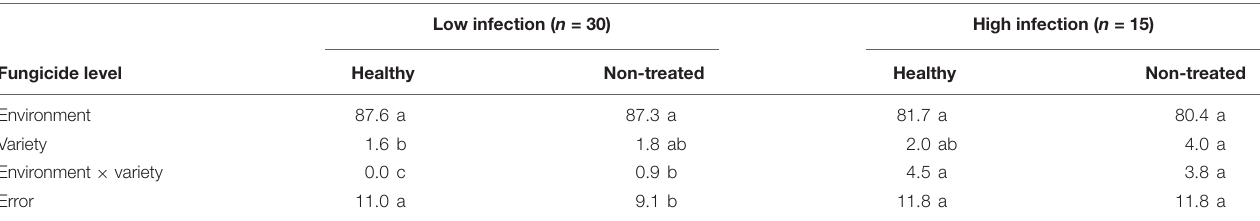
TABLE 5 | Estimation of variance components (%) for factors influencing white sugar yield of sugar beet at low and high disease severity of Cercospora leaf spot and two fungicide levels (non-treated/healthy); 15 varieties tested at 45 environments in Germany